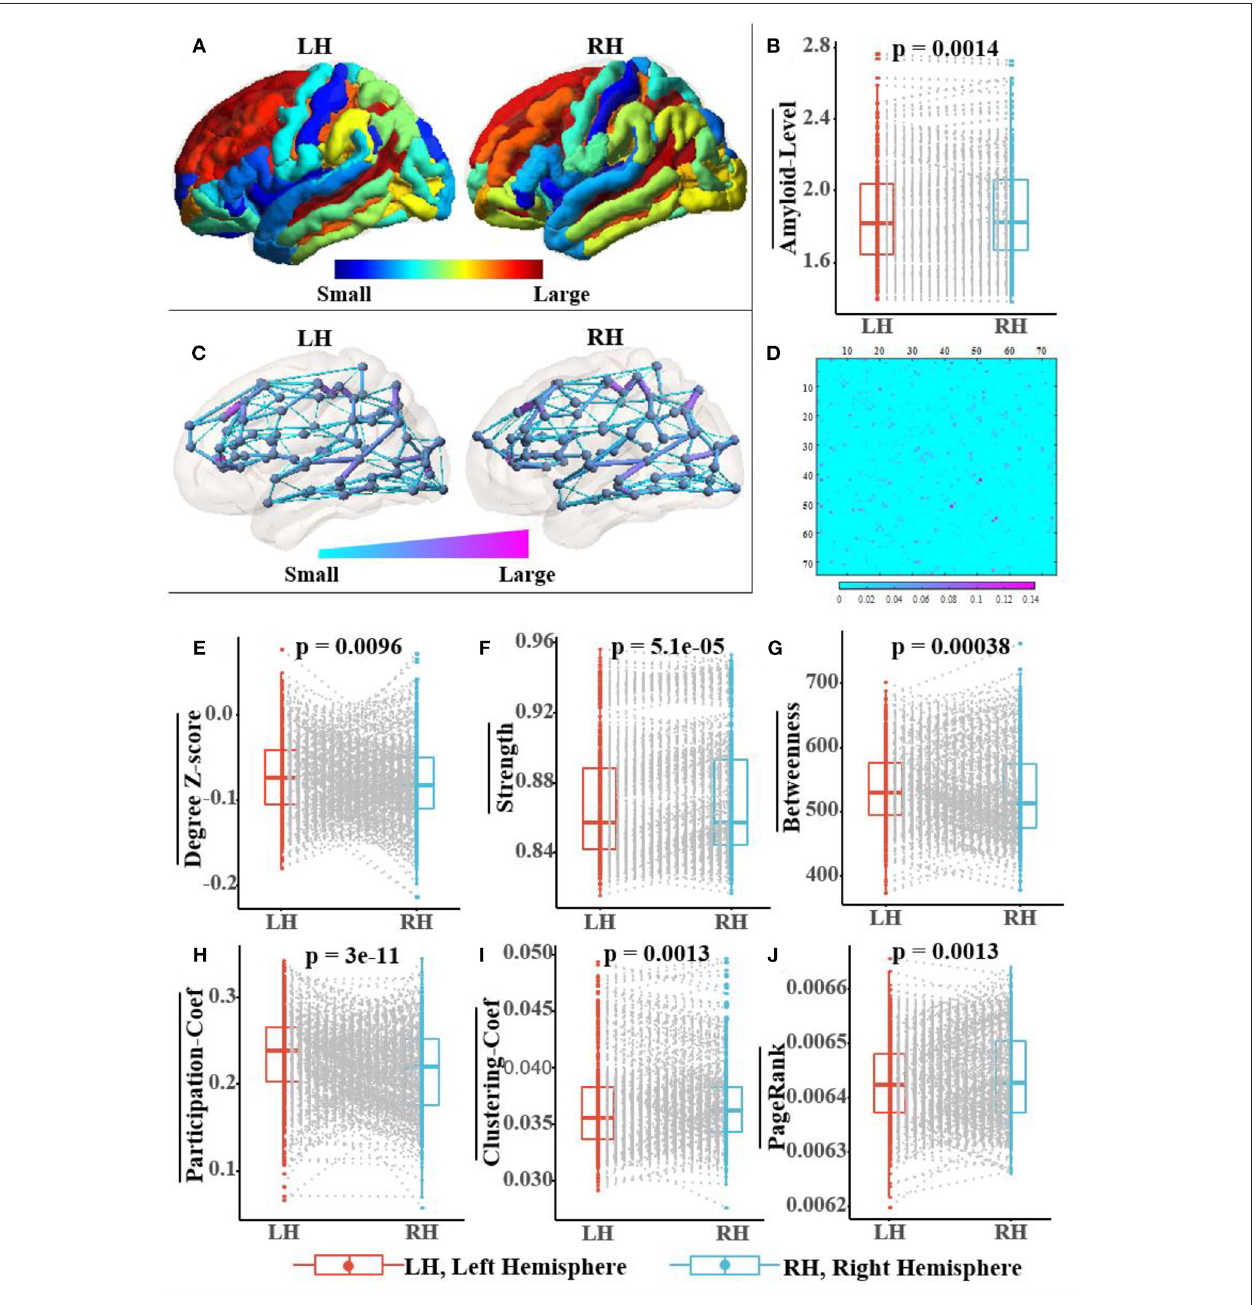
FIGURE 7 | Population-wide comparison between left and right hemispheres. Panel (A) exhibits the average amyloid level map of the corresponding brain regions on the left and right hemispheres. Panel (B) shows the paired comparison box plots of the average amyloid levels for the respective brain regions in the left and right hemispheres. Panel (C) exhibits the population topological structures of the left and right hemispheres. Panel (D) displays the difference matrix of the adjacency matrix of the left and right hemispheres. Panel (E–J) show the paired comparison box plots of the six graph measures of the brain networks from the left and right hemispheres, respectively. Pairs of brain regions in the left and right hemispheres with the same name are matched in the paired samples Wilcoxon